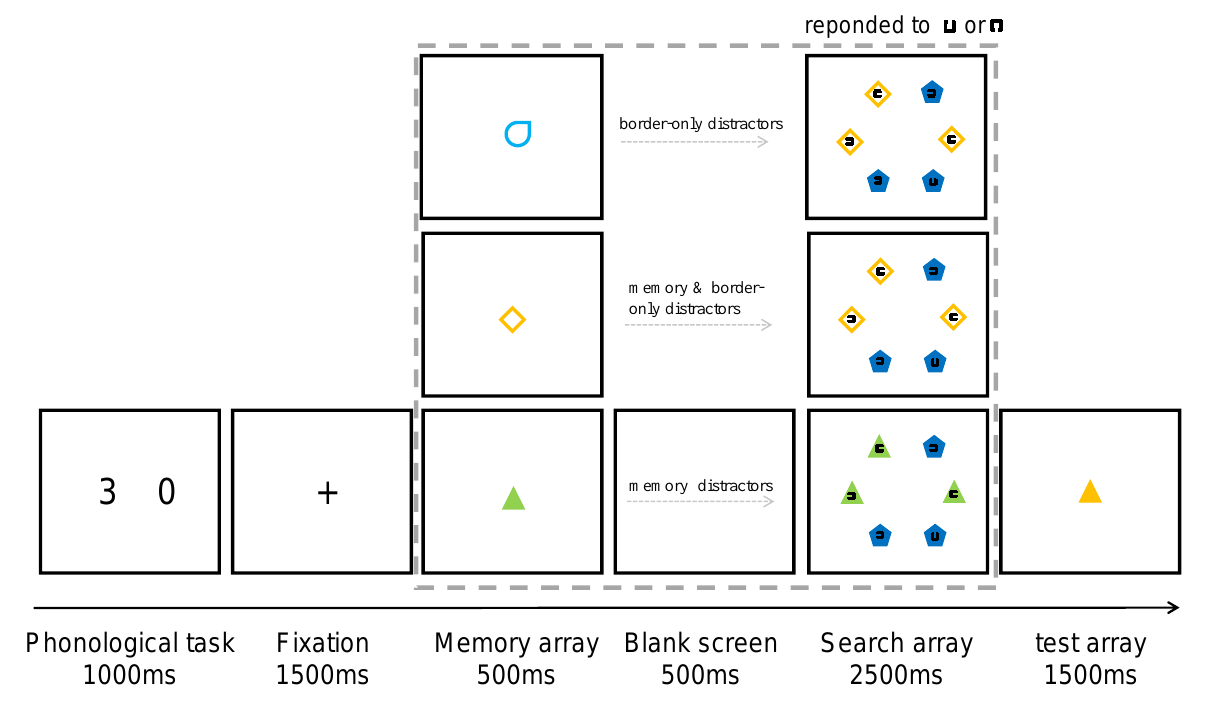
Figure 3. Trial structure of the dual-task paradigm in Experiment 2.